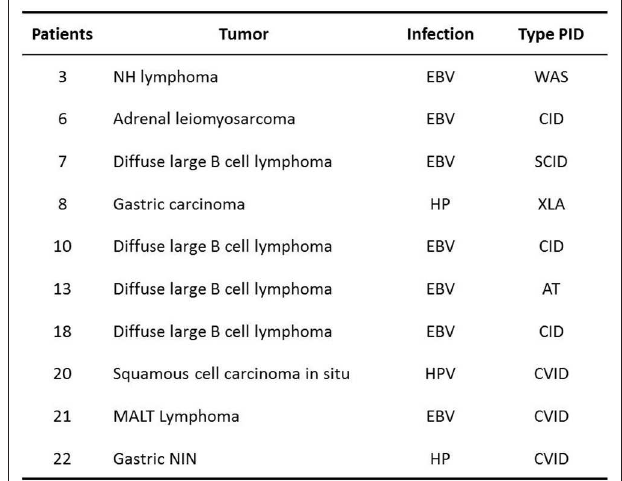
FIGURE 5 | Tumors and